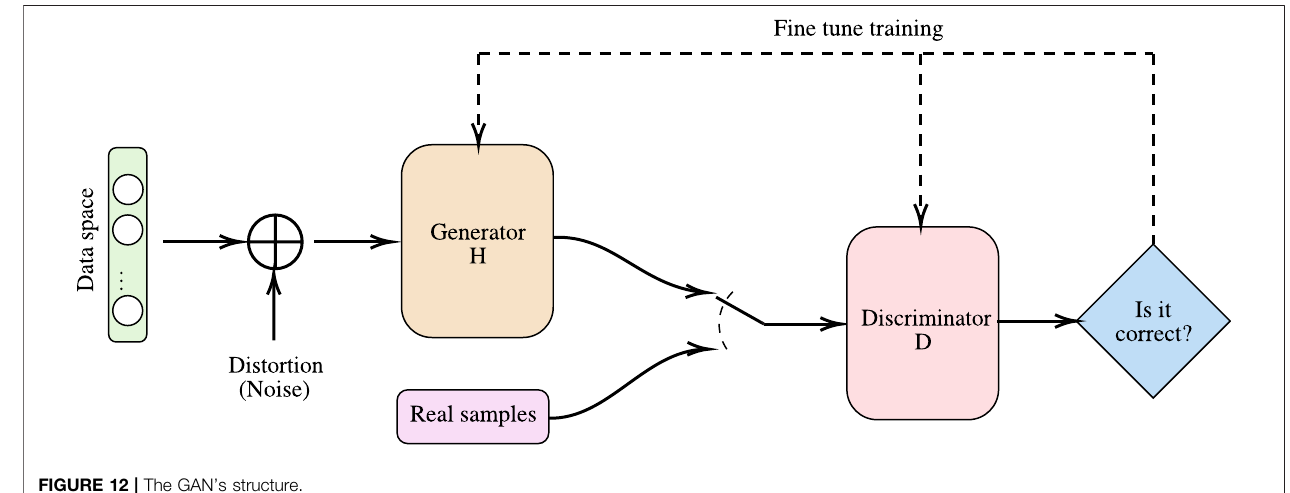
FIGURE 12 | The GAN ’ s